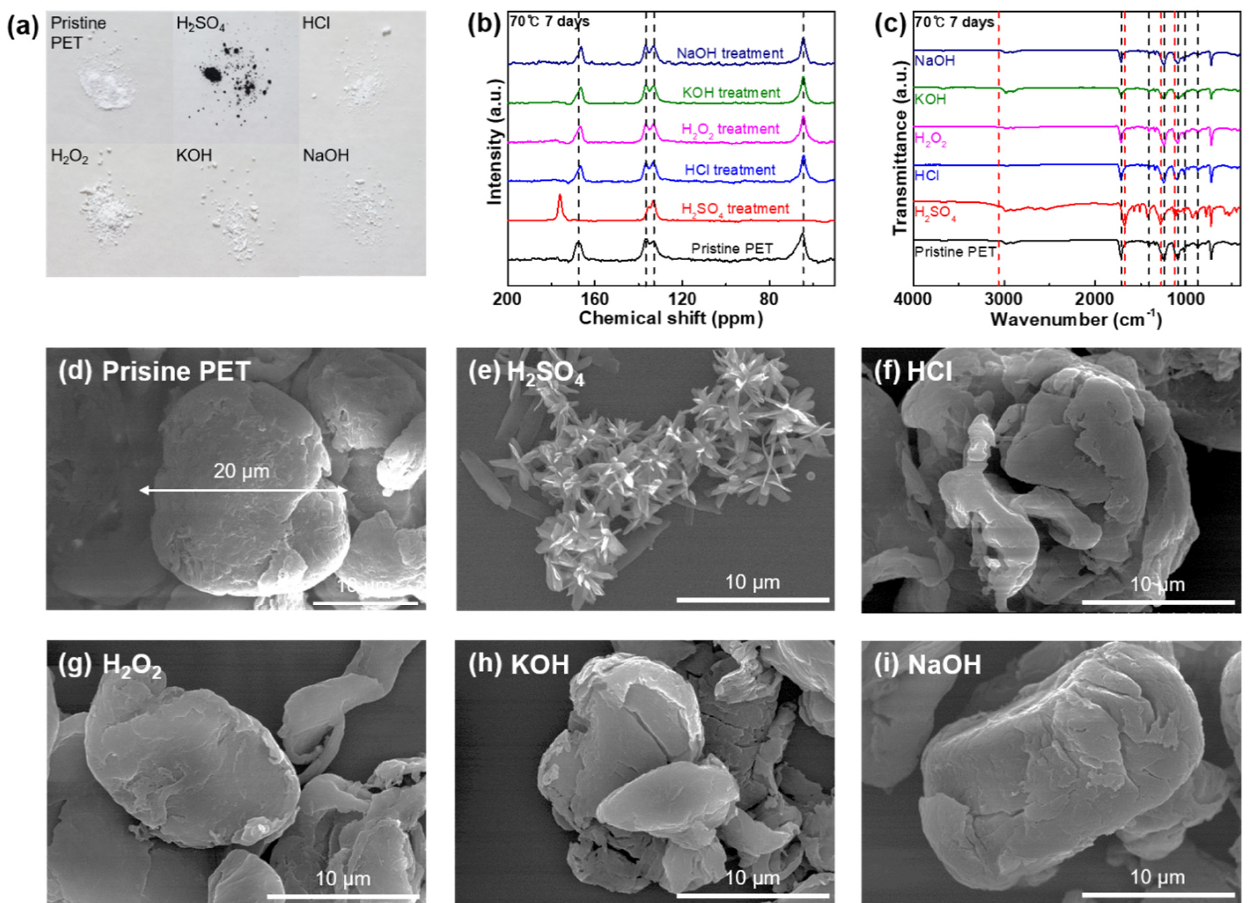
Figure 5. ( a ) Photograph of the PET samples of pristine state and after chemical stability tests against strong acids, bases, and oxidizing agents (H 2 SO 4 , HCl, H 2 O 2 , KOH, and NaOH) used in the chemical digestion procedure at 70 °C for 7 d. ( b ) 13 C NMR spectra of PET in the pristine state and after the reaction with all the chemical agents at 70 °C for 7 d. ( c ) FT-IR spectra of PET in the pristine state and after the reaction with all the chemical agents at 70 °C for 7 d. ( d ) SEM image of pristine PET microparticles. SEM images of the PET microparticles after the reaction with ( e ) H 2 SO 4 , ( f ) HCl, ( g ) H 2 O 2 , ( h ) KOH, and ( i ) NaOH at 70 °C for 7 d.